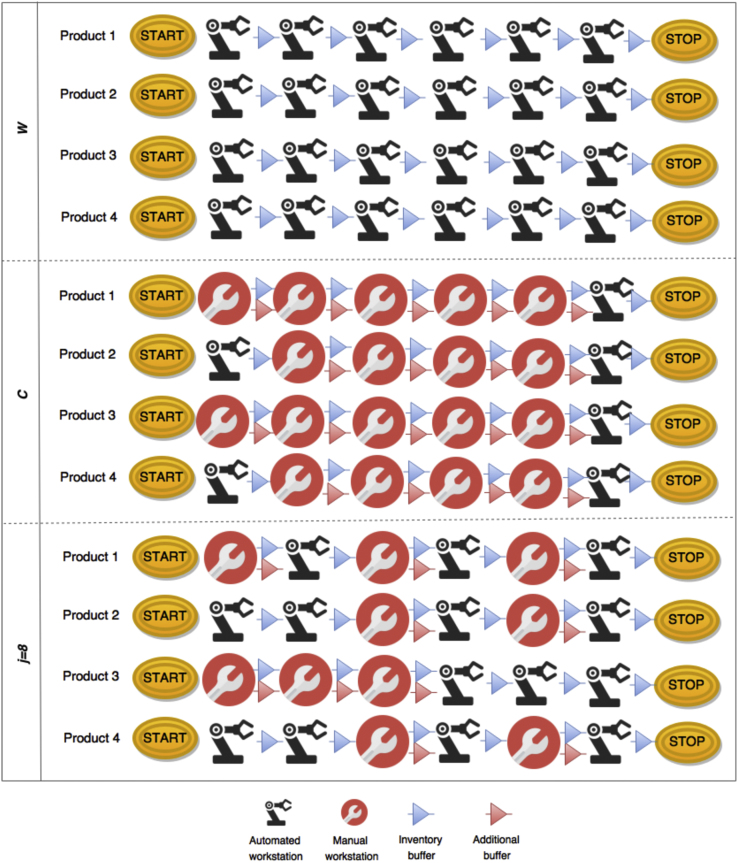
Assembly layouts for solutions in points W, C and j=8 [1].